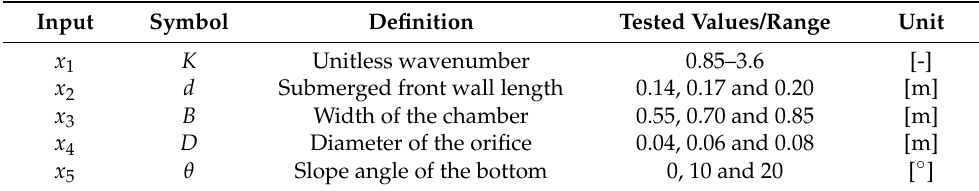
Figure 1. Definition sketch for the independent variables (simplified from [15]: reprinted from Energy Vol 83, De-Zhi Ning, Jin Shi, Qing-Ping Zou, Bin Teng, Investigation of hydrodynamic performance of an OWC (oscillating water column) wave energy device using a fully nonlinear HOBEM (higher-order boundary element method), Pages 177-188, Copyright 2015, with permission from Elsevier.). Table 1. Description of the independent variables.